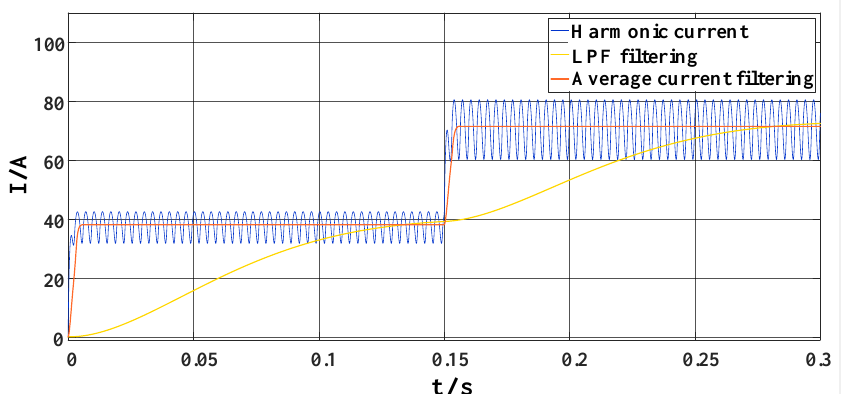
Figure 8. Comparison of LPF filtering and average current filtering schemes.